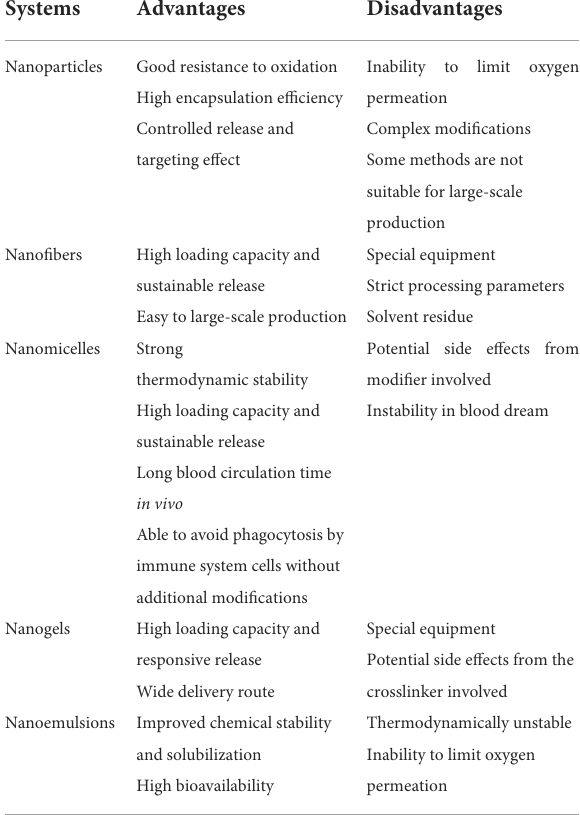
TABLE 2 Advantages and disadvantages of different nano-sized delivery